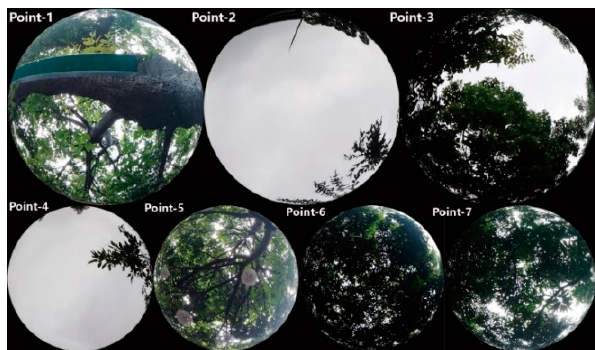
Figure 7. Hemispherical photo of the selected points.